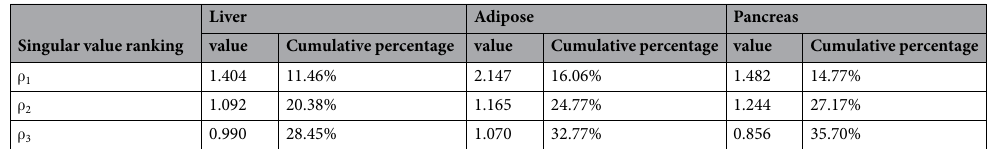
Table 1. The top three singular values of the three tissue-specific expression profiles and their